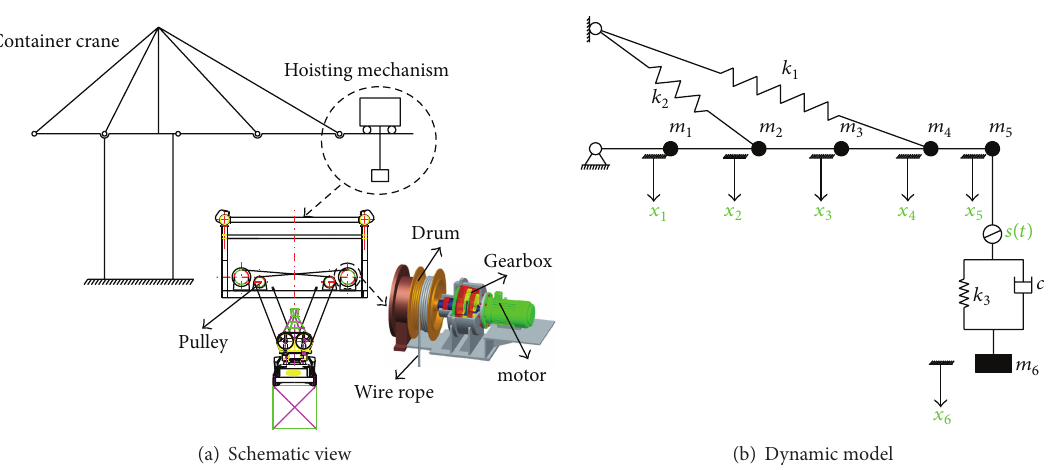
Figure 4: Schematic view and dynamic model for hoisting mechanism.